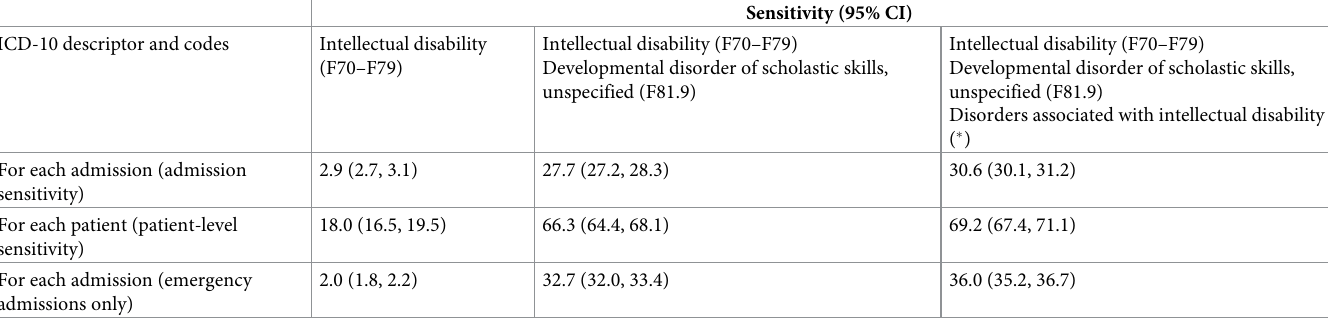
Table 2. Sensitivity of recording of intellectual disability in English general hospital records 2006–2019 for individual admissions and for individual patients by ICD-10 code